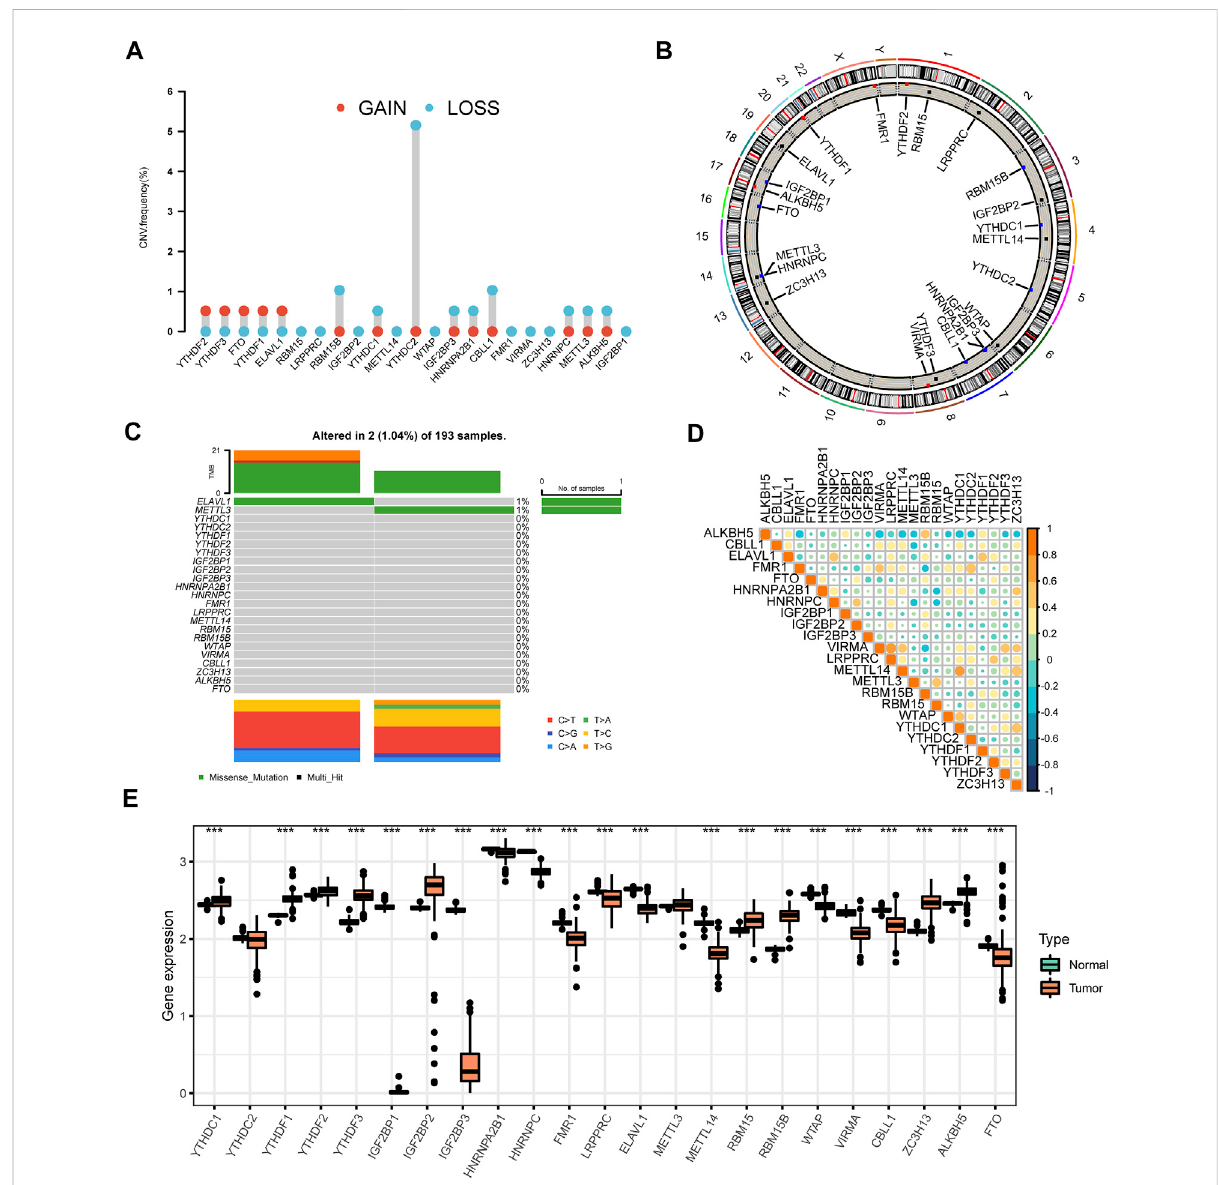
The panorama of genetic variations and expression patterns of m6A regulators in AML (A) The CNV variation frequency of 23 m6A regulators was prevalent from the TCGA cohort. The height of the column denoted the alteration frequency. The ampli fi cation frequency was labeled as a red dot. The deletion frequency was labeled as a blue dot (B) The location of CNV alteration of m6A regulators on chromosomes. The black dot, the red dot,andthebluedotintheringindicatednocopynumberchange,ampli fi cation,anddeletionrespectively (C) Thegeneticalterationfrequency of 23 m6A regulators in 193 patients with AML. The upper bar plot showed TMB. The panel on the right represented the mutation frequency and proportion of each variant type in each regulator (D) Correlation of the investigated m6A modi fi cation regulators (E) The differences of expression levels of 23 m6A regulators between normal and AML samples (*** p <